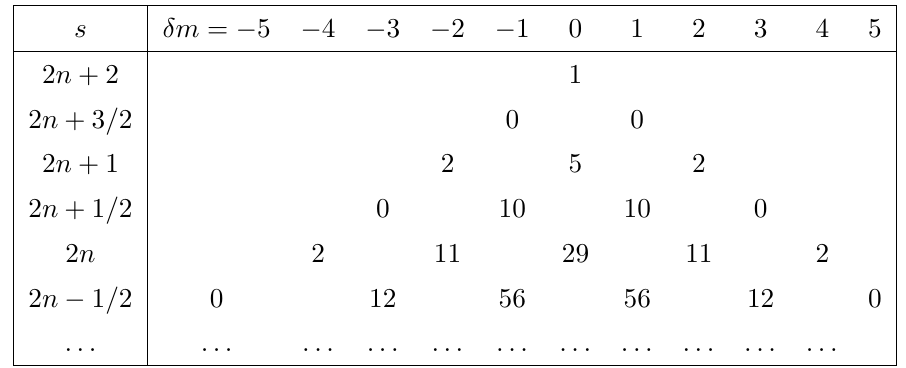
Table 5 . Number of the Z 2 -even N = 4 multiplets for (cid:22) r = 0 organized by their su (2) quantum numbers. This is to be compared to table